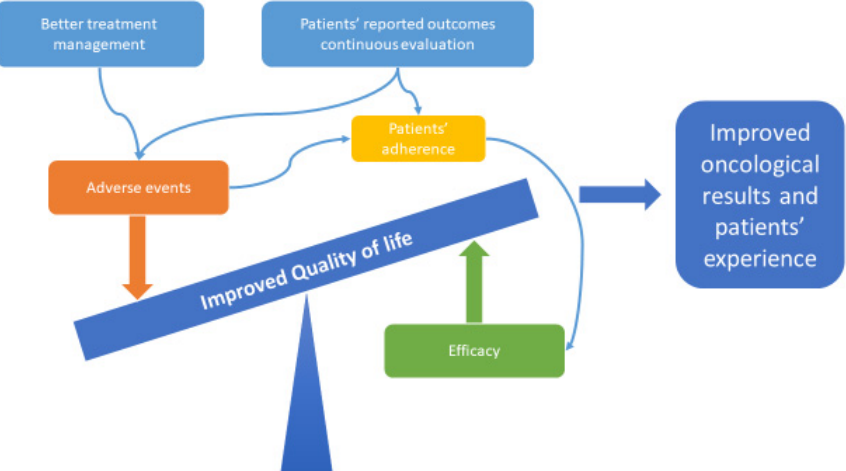
Figure 1. Treatment and quality of life.